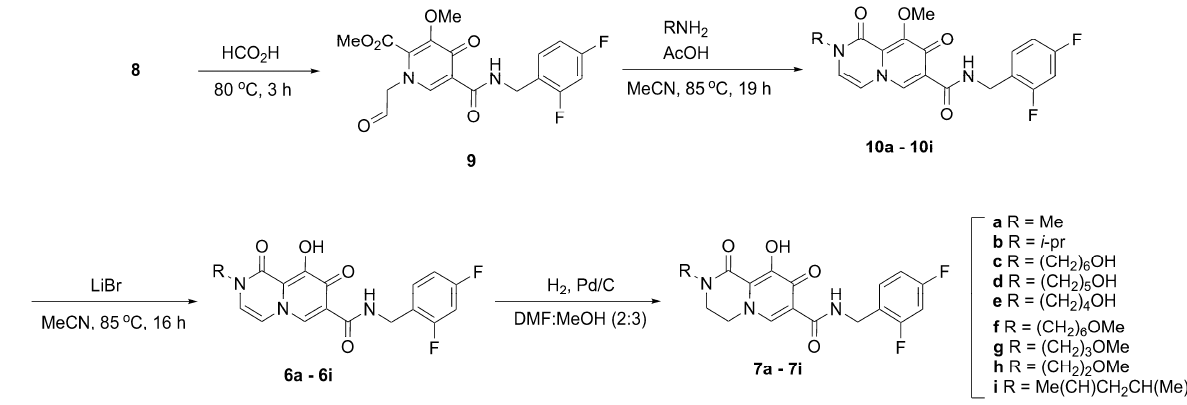
Scheme 1. Synthetic approach to bicyclic carbamoyl pyridone derivatives 6 and 7